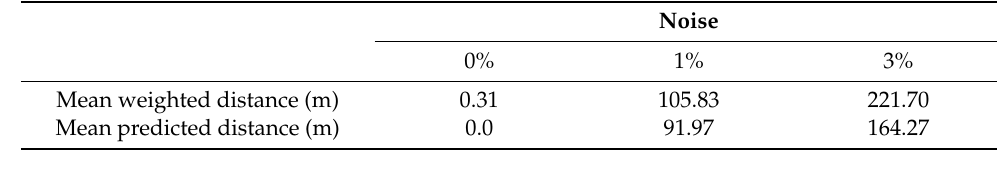
Table 15. Inference mean values for node 285, with noise.